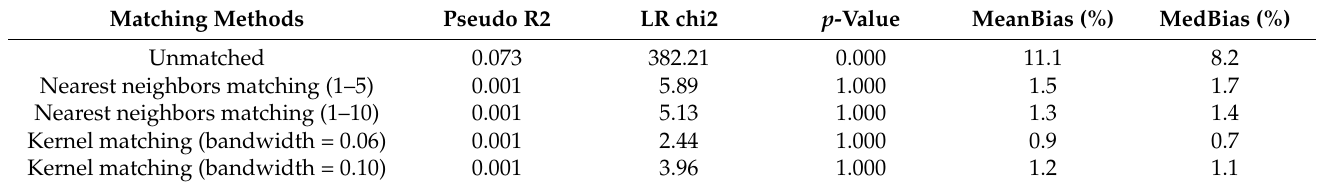
Table 13. Balancing test results for independent variables before and after matching (outcome variable: Physical exercise). Matching